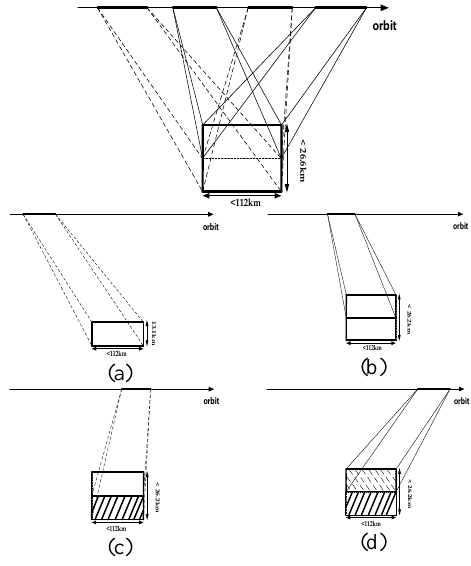
Figure 2. Demonstration of the stitched stereo imaging mode (the situation of dual